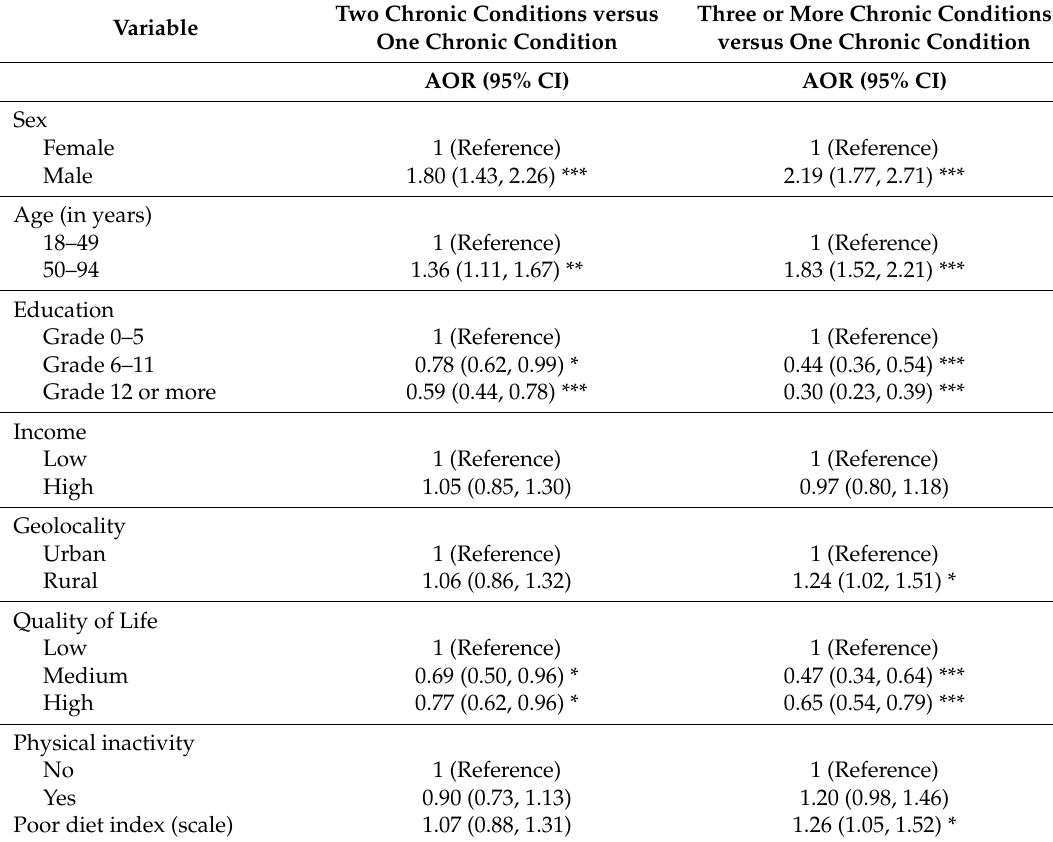
Table 3. Multinomial logistic regression model examining correlates of